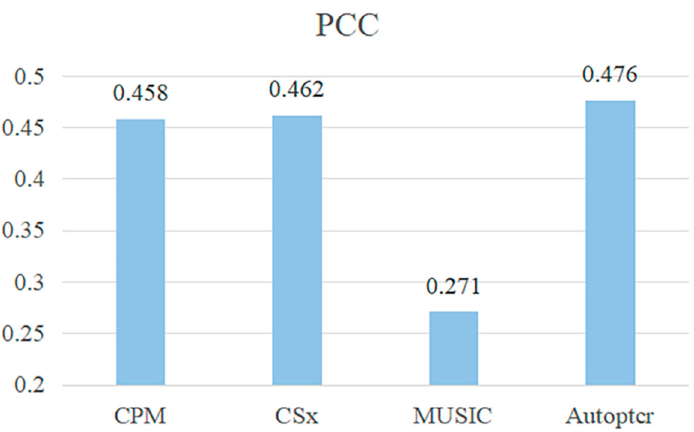
Figure 7. PCC of CPM, CSx, MusiC, and Autoptcr on PBMC2.